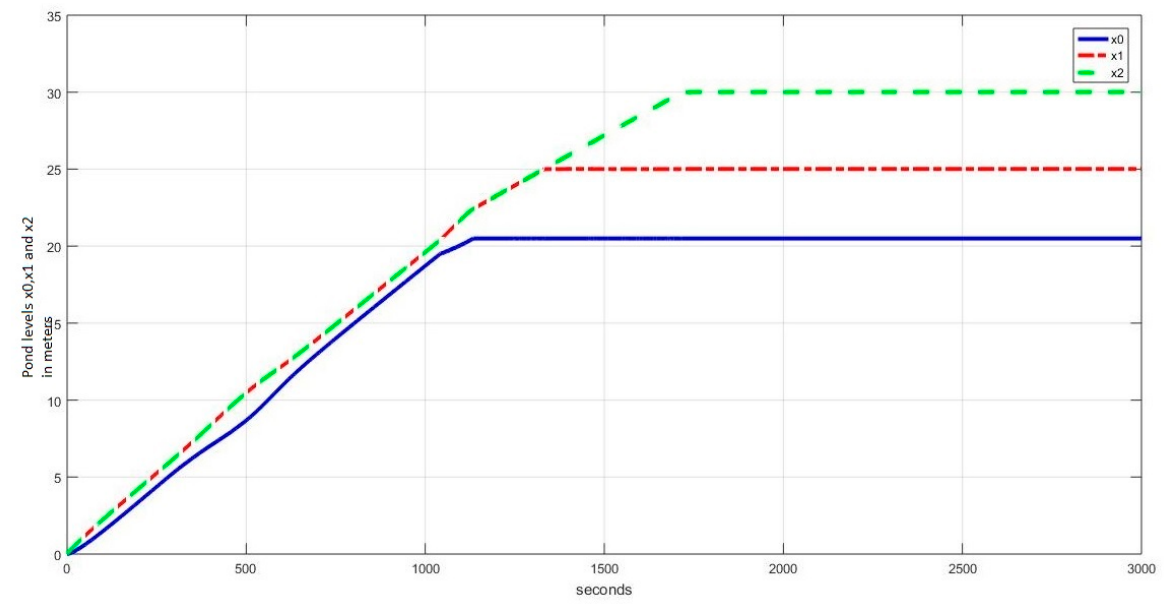
Figure 12. Desired Level T 0 at 20 m, T 1 at 25 m, and T 2 at 30 m vs.